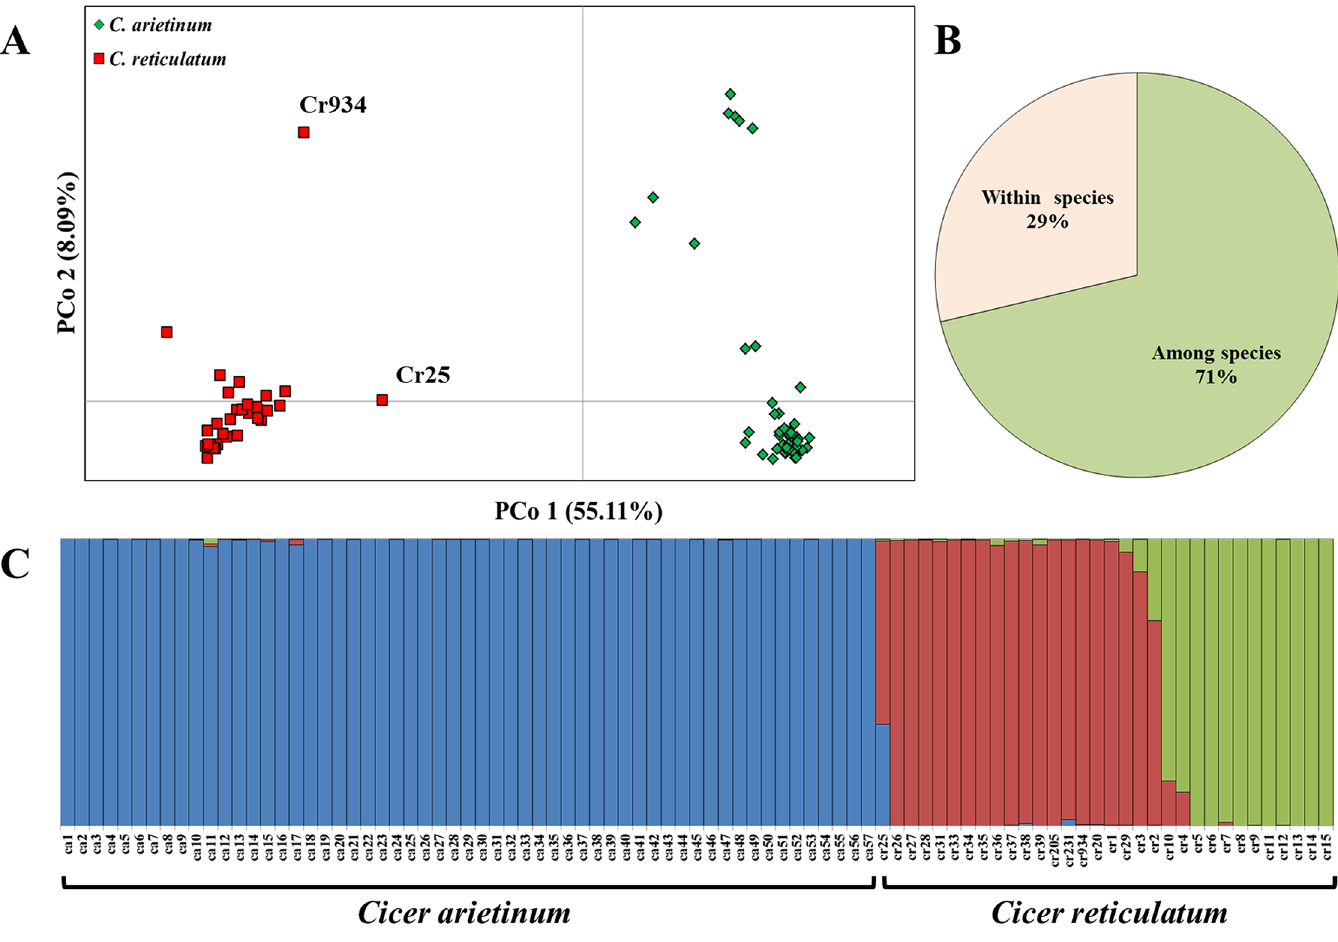
Fig 4. Genetic relationships between wild and domesticated Cicer sp. ( A ) A principal coordinate (PCo) plot of pairwise individual genetic distances among wild Cicer reticulatum and domesticated C . arietinum genotypes. ( B ) Estimated population structure based on allele frequency variation of SNPs markers. Each genotype is represented by a vertical bar, which is partitioned into K- colored components representing the ancestry fractions in K = 3 clusters. Individual genotypes are ordered by species (labeled below).